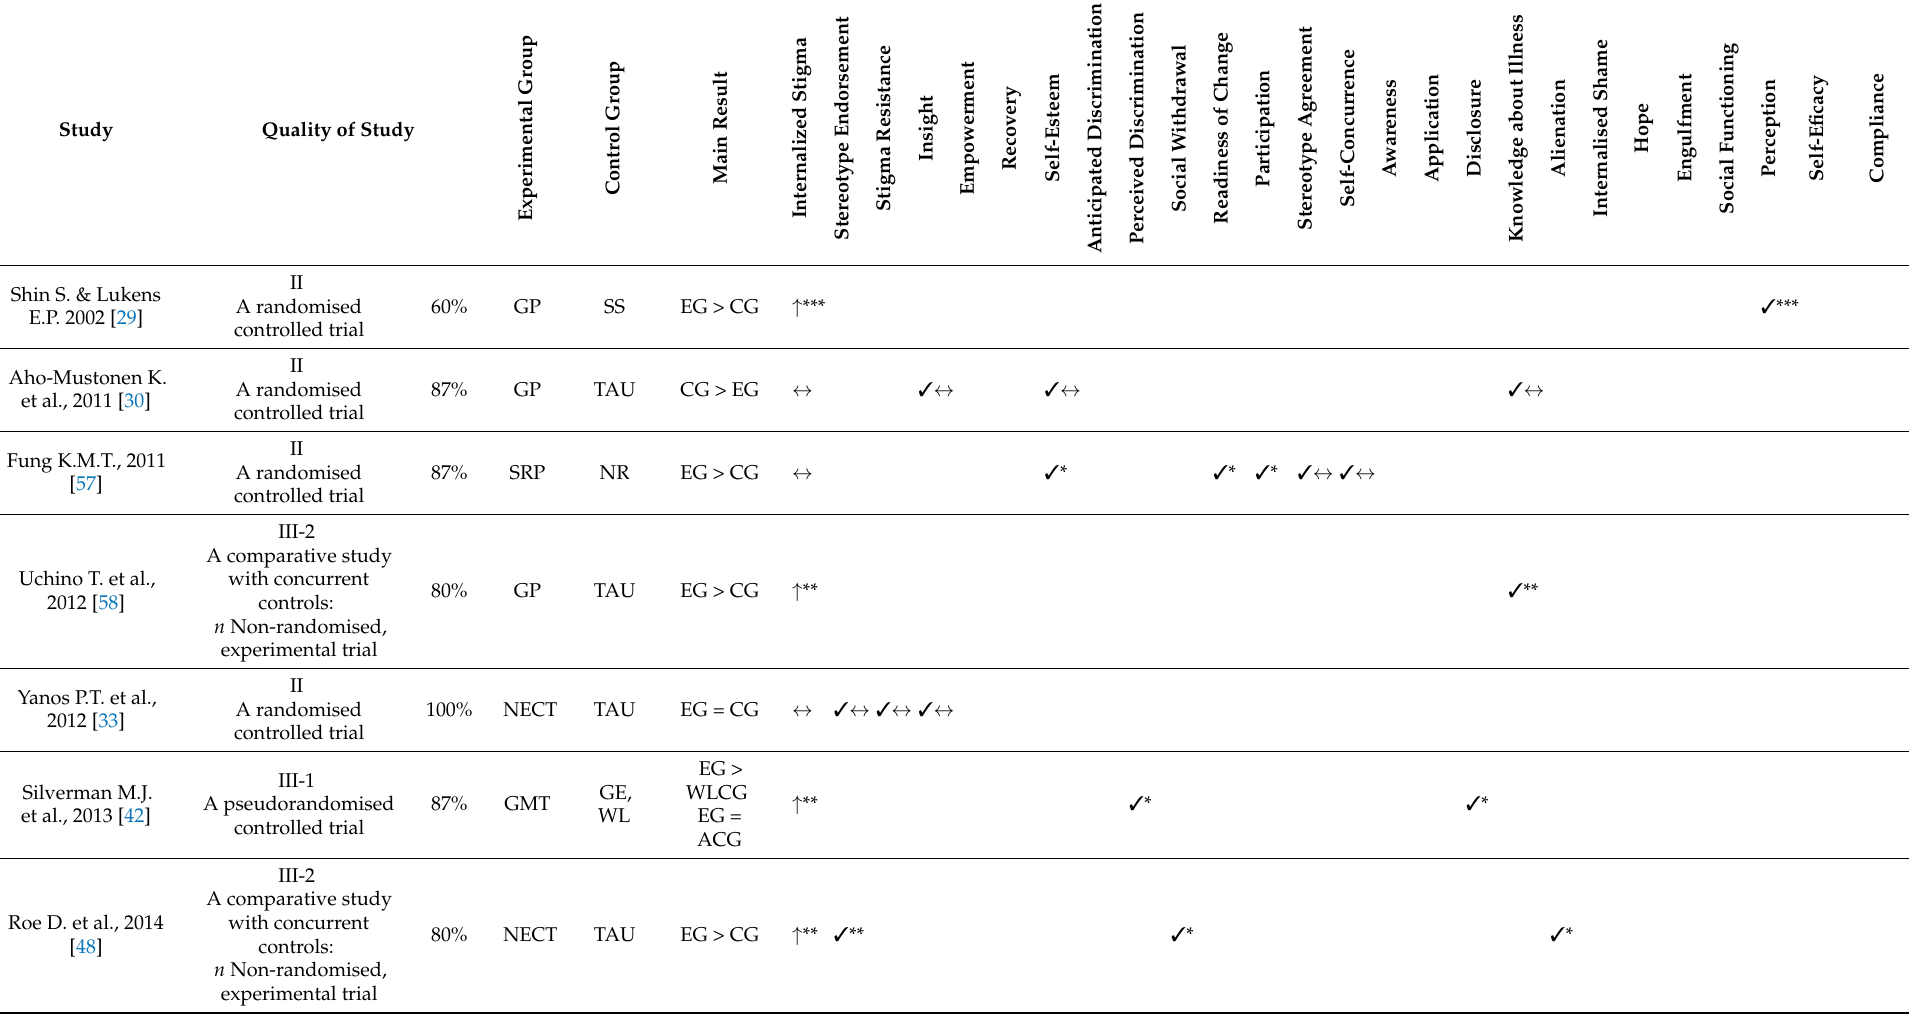
Table 2. Summary of the findings of interventions for internalized stigma